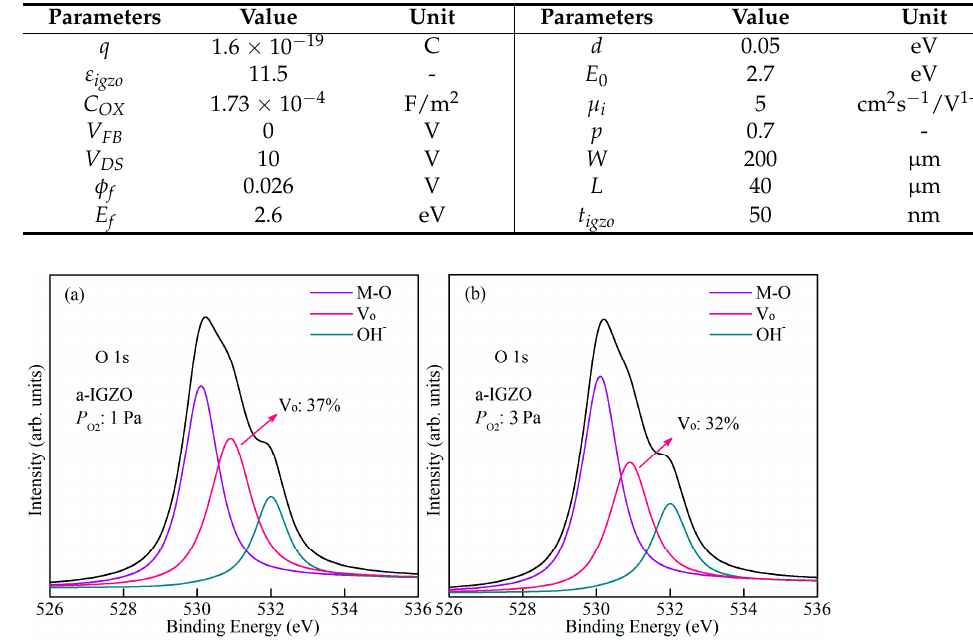
Table 1. Key parameters used in the model.